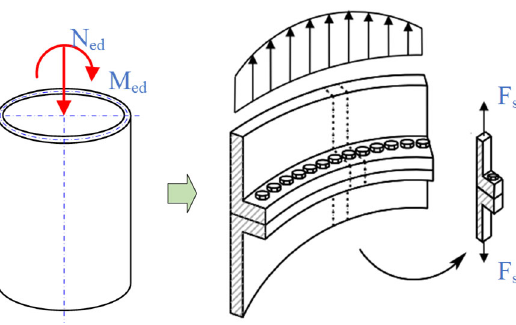
Figure 3. Stress–strain curve [23]. Figure 4. Tensile force applied to L ‐ type flange segment.